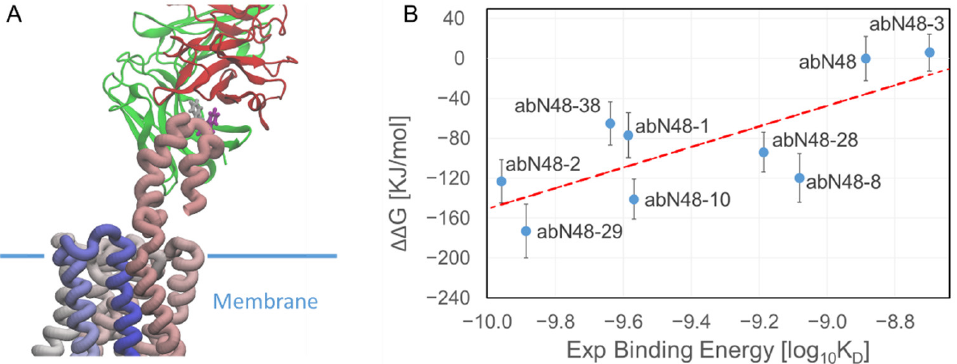
Figure 1. Correlation between experimental binding affinity and computed binding free energy. ( A ) Illustration of the abN48-CXCR2 system. The light chain and heavy chain of abN48 in FAB format are shown in in red and green, respectively. The CXCR2 protein is shown as a ribbon; the color goes from pink ( N -terminal) to blue ( C -terminal). Phe14 (gray) and Trp15 (purple) of CXCR2 are the main contributors to the interaction with the pepN9-19. The structure of the N-terminal of CXCR2 is not known except for the crystalized residues and is modeled here as a random coil. ( B ) Correlation between the binding affinity ∆∆ G and the log 10 of the experimental K D . The correlation coefficient between the two sets of data was R 2 =